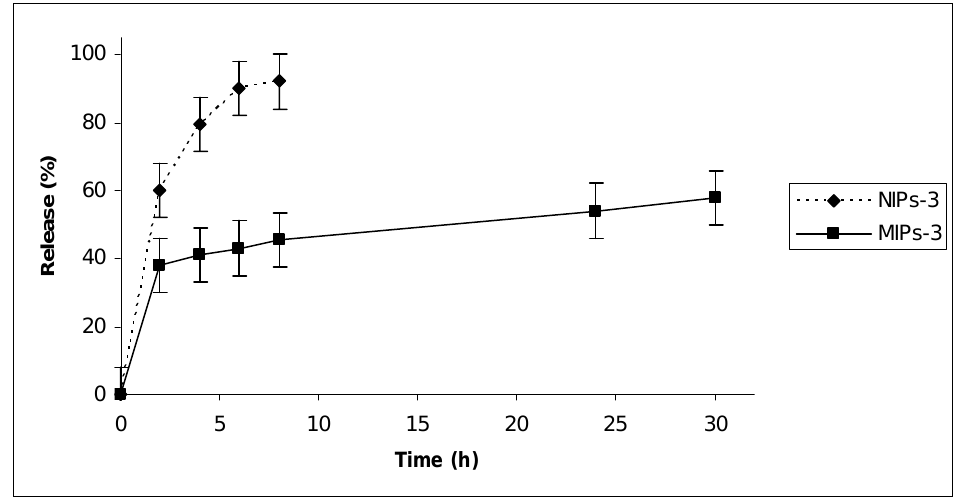
Figure 5 : Release profile of 5-FU from MIP-3 and NIP-3 in plasma simulating